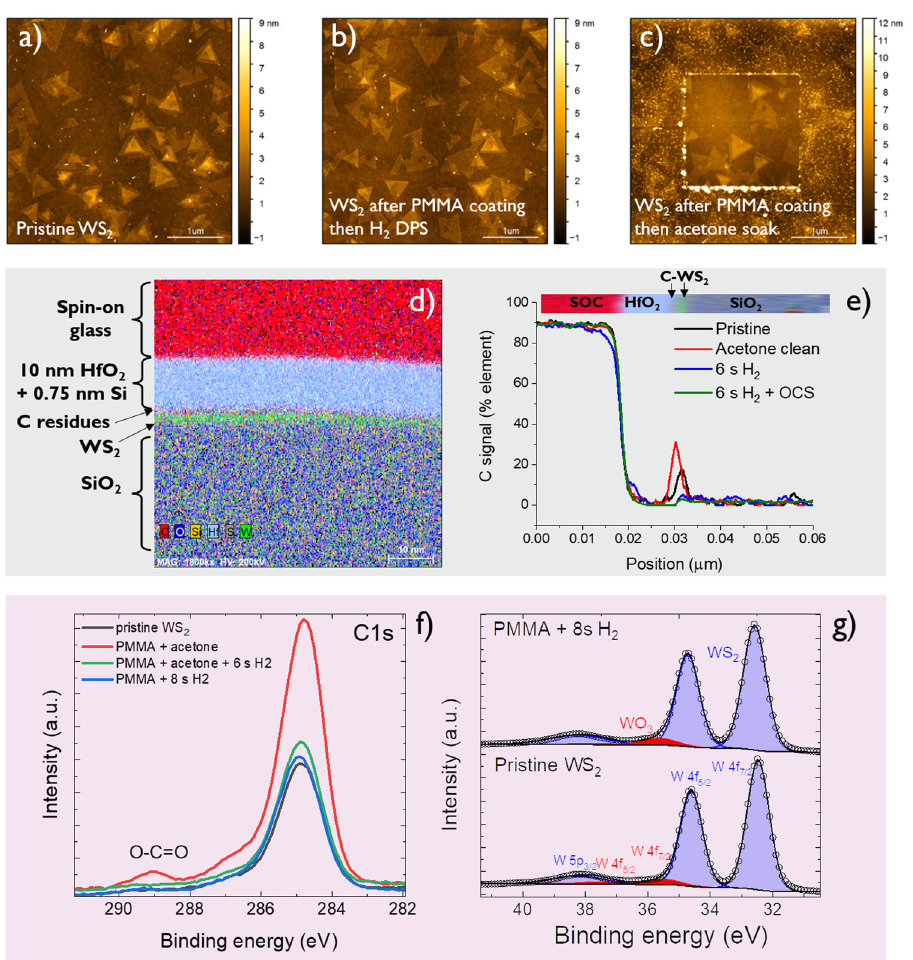
Fig. 3 Morphology and surface chemistry of WS 2 fi lms before and after cleaning treatments. Topography AFM images: a pristine as-grown material; b 200 nm PMMA removed by 8 s H 2 plasma strip at 300 ∘ C; c PMMA removed by 2 h acetone soak, A 2 μ m × 2 μ m square in the center of the image was mechanically cleaned by the AFM tip. Cross-section TEM imaging: d illustrative EDS-TEM cross-section image of a WS 2 sample after close-coupled deposition of a 10 nm HfO 2 layer (using a initiation layer of 0.75 nm Si deposited by PVD); e integrated carbon elemental pro fi ling for various cleaning treatments. Chemical characterization using XPS: f C1s spectra measured after different PMMA removal approaches; g W4f core spectra of pristine WS 2 and after plasma removal of 200 nm